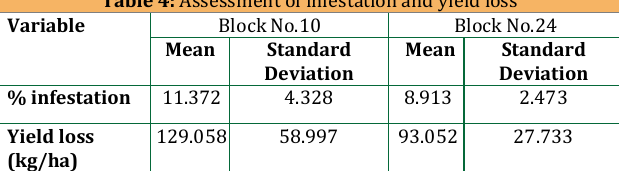
Table 4: Assessment of infestation and yield loss Variable Block No.10